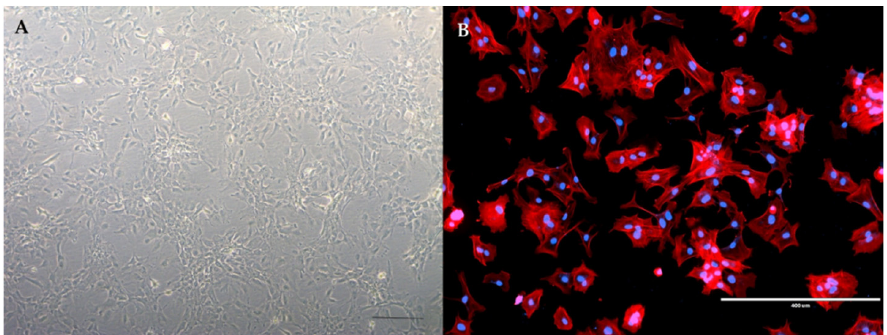
Figure 1. ( A ) The primary culture of human astrocytes in low-density culture. Individual polygonally shaped cells are evident. Images were taken at ×50 magnification on Zeiss Axiovert 40 inverted microscope. Scale bar = 200 µm. ( B ) The immunocytochemical characterization of human astrocytes. The cell morphology was appreciated with orange fluorescent phalloidin conjugate, selectively binding to actin filaments (red). In low-density cultures, astrocytes show a polygonal shape with actin filaments adjacent to the cell membrane. Nuclei were counter-stained with 4 ′ ,6-diamidino-2-phenylindole (DAPI) blue. Images were taken at ×10 magnification on EVOS FL fluorescence microscope. Scale bar = 400 µm.